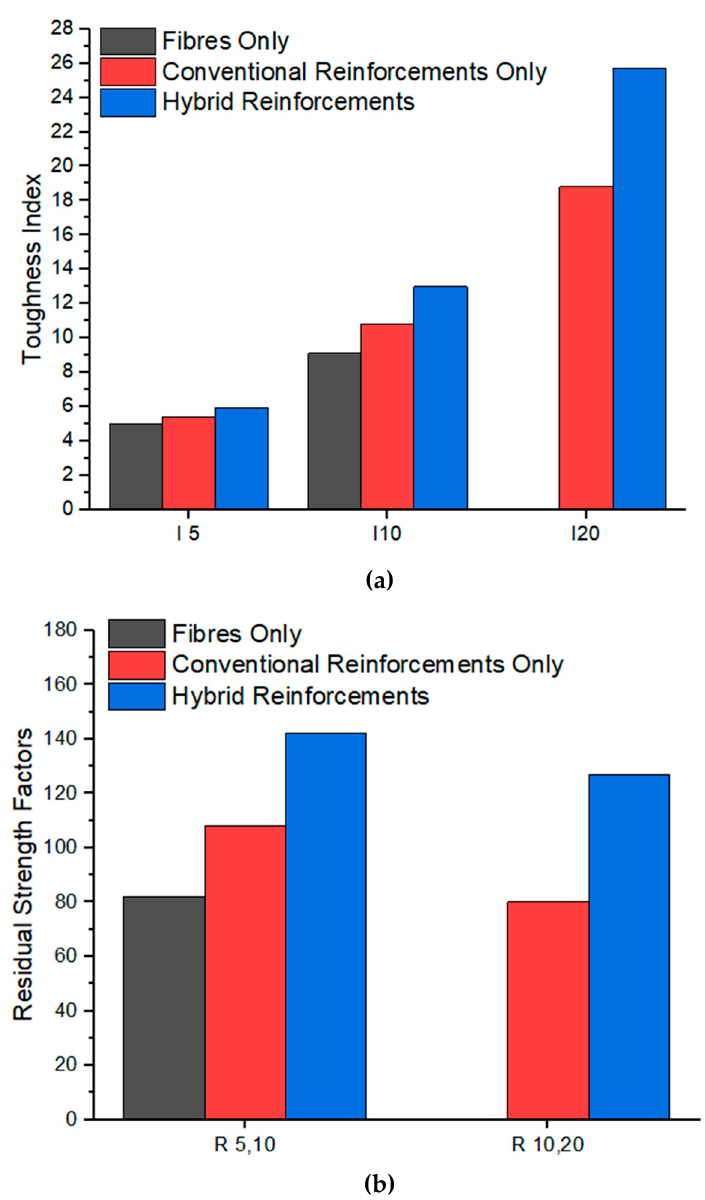
Figure 10. Toughness indices ( a ) and residual strength factors ( b ) of AAC beams in